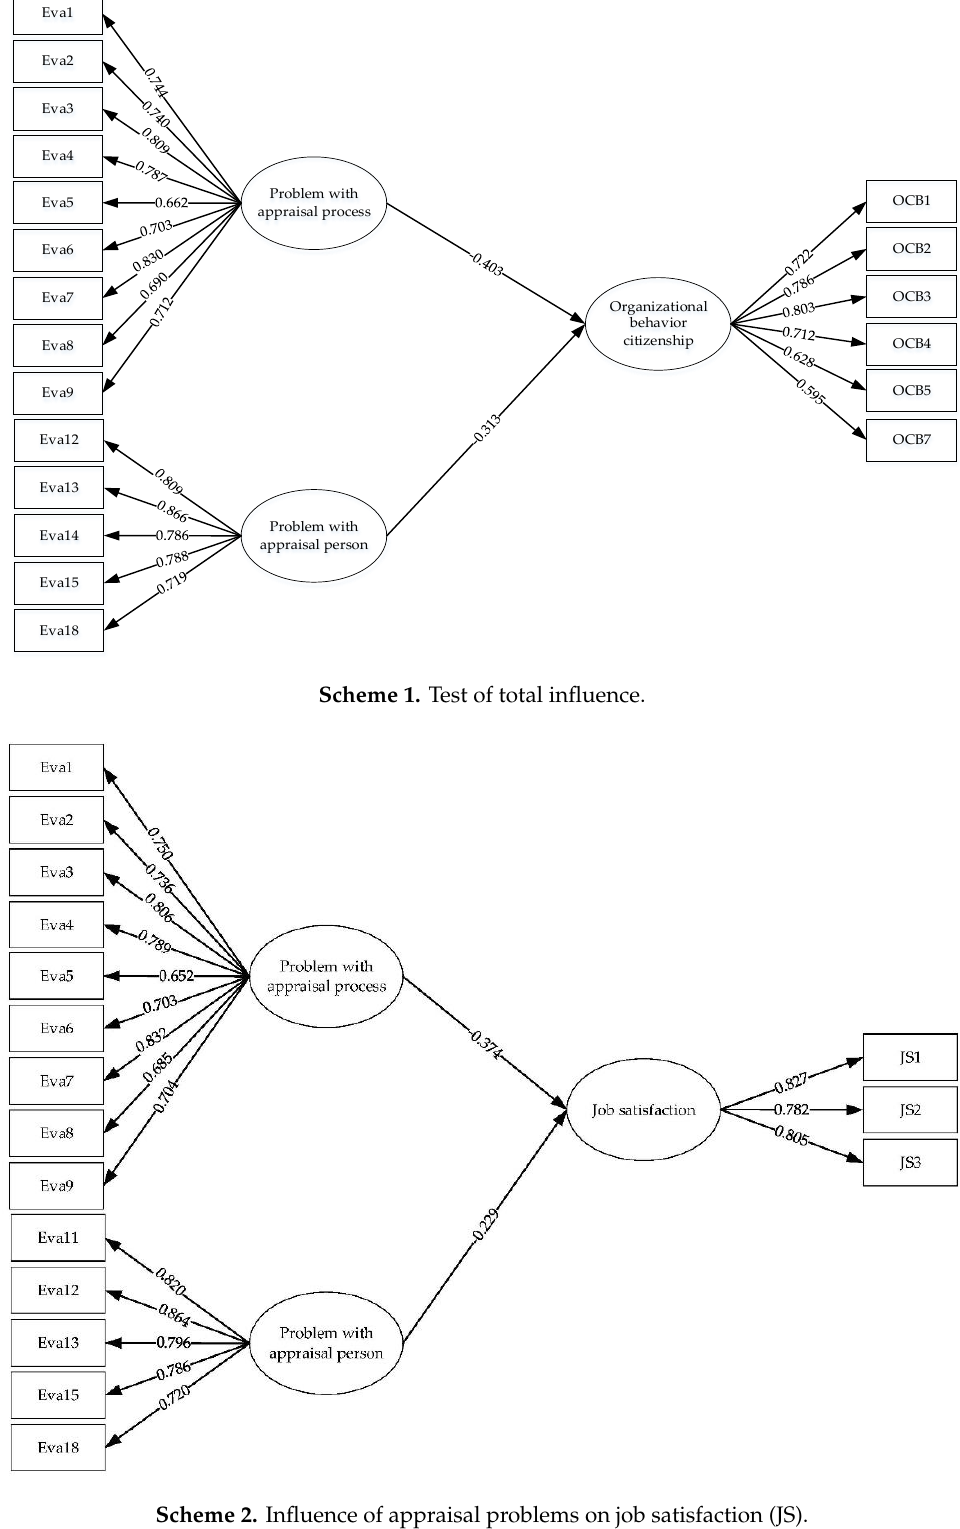
Scheme 2. Influence of appraisal problems on job satisfaction (JS).